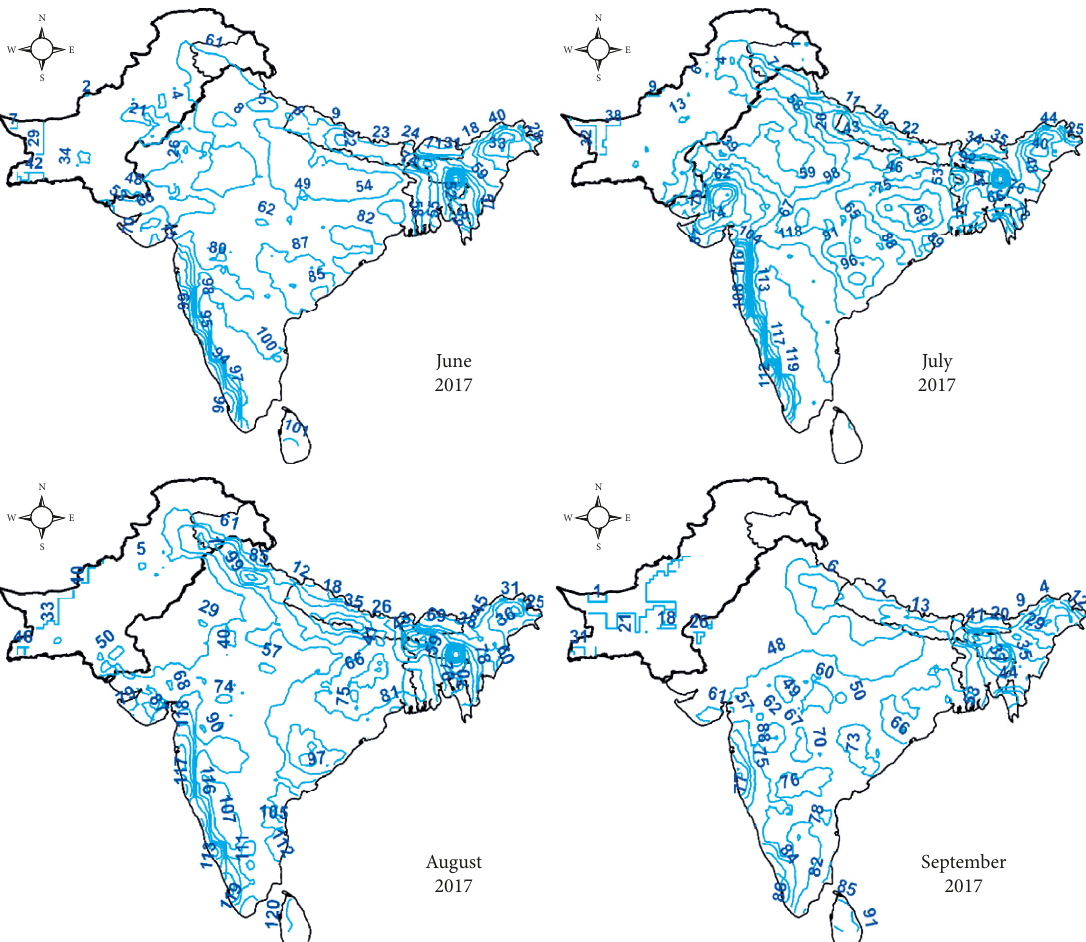
Figure 2: Map of monsoon region over the Indian subcontinent depicting isohyets for the year 2017. Monsoon rainfall depicting the active monsoon period over Pakistan: month of June has a small spread of monsoon rainfall in Pakistan, while July and August are the months with widespread rainfall in